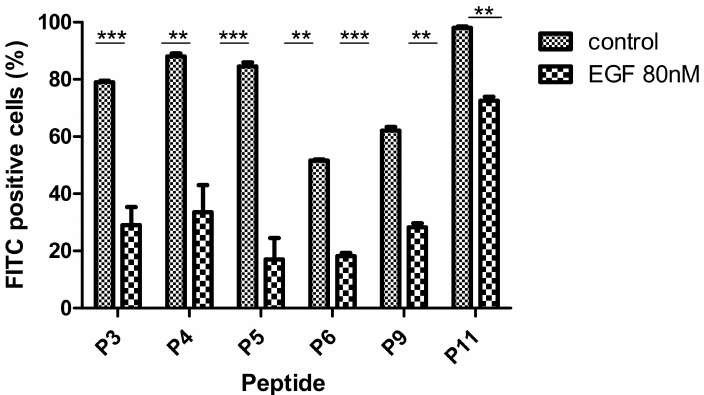
Figure 3. Competitive uptake of P3, P4, P5, P6, P9, and P11 peptides by FACS. Fluorescence was measured for H1299 cells (30,000 cells) after incubation with (2.5 µ M) P3–P6, P9, and P11 by FITC- labeled peptides in the absence or presence of 80 nM of the EGF protein. The experiments were performed in duplicate. For each sample, the mean ± SD is shown (** p < 0.01, *** p < 0.001).